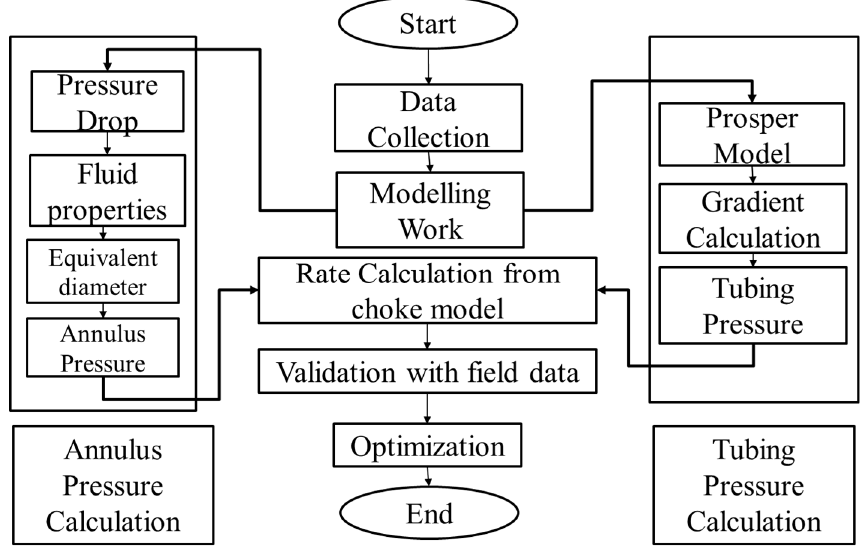
Figure 3. Process flow of split factor modelling.